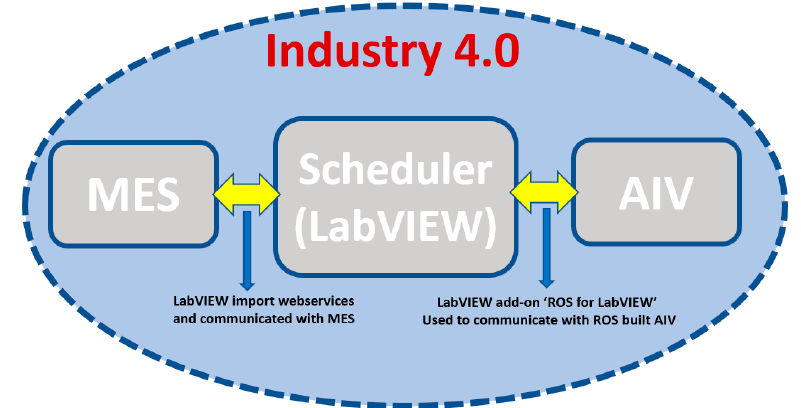
Figure 2. Proposed Manufacturing Execution System (MES) and Autonomous Intelligent Vehicle (AIV) integration.